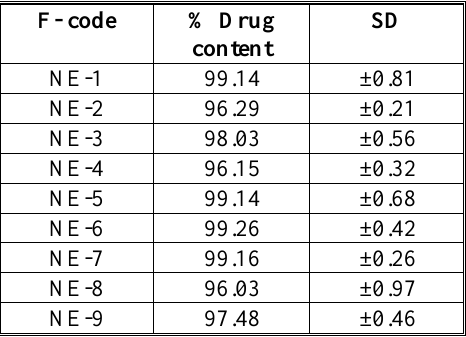
Table 8.Drug content of LCDP formulations (mean ±SD, n=3).